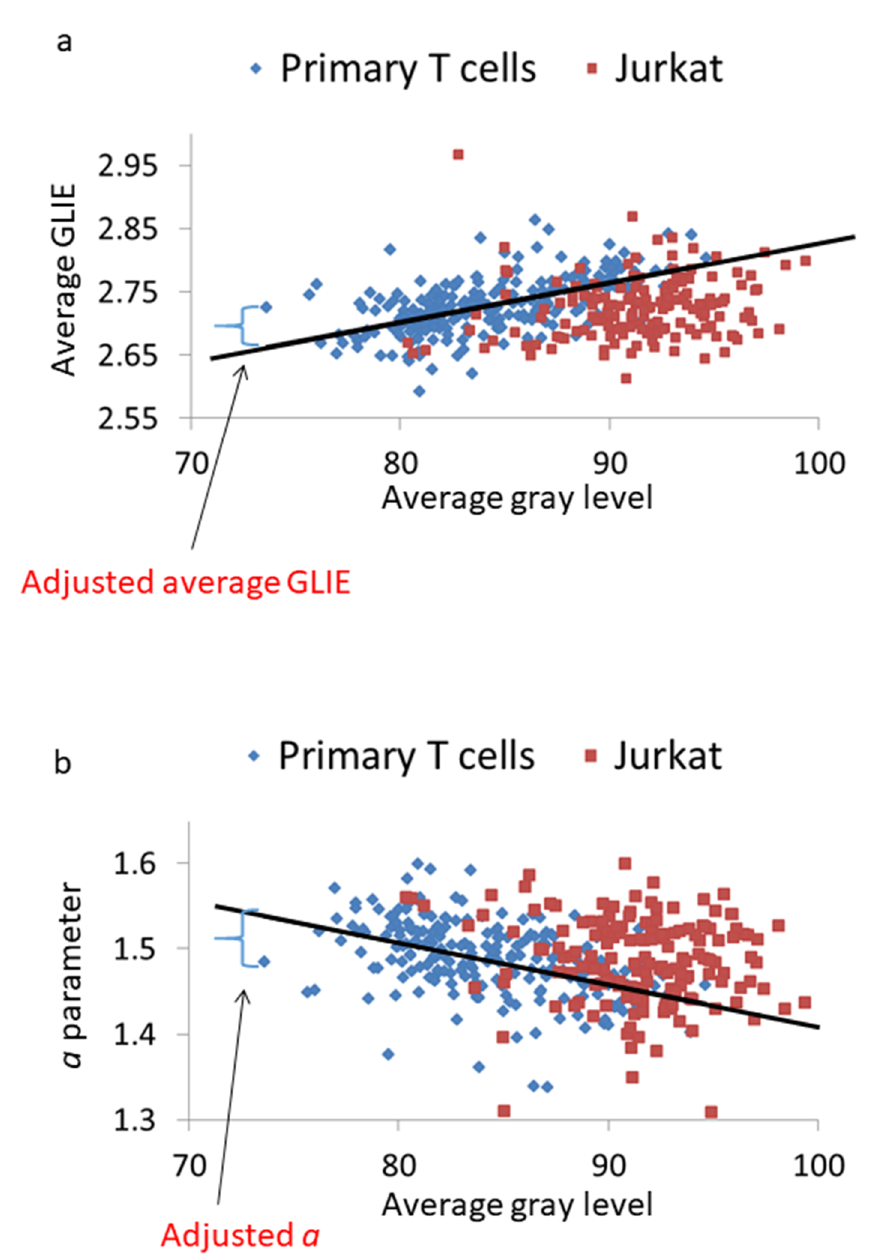
Figure 11. Adjusting for the influence of average gray level on the average GLIE and a parameters values. ( a ) Average GLIE values according to the average gray level in primary T cells and Jurkat cells. The linear regression line for that correlation in primary T cells is presented (that linear regression equation is also presented in Figure 10a). Relating to this linear regression, an example of adjusted GLIE parameter value which is calculated from the difference between the measured average GLIE value and the expected value from the linear regression function is presented. ( b ) Parameter a values according to the average gray level in primary T cells and Jurkat cells. The linear regression line for that correlation in primary T cells is presented (that linear regression equation is also presented in Figure 10e). Relating to this linear regression, an example of adjusted a parameter value, which is calculated from the difference between the measured a parameter value and the expected value from the linear regression function, is presented.